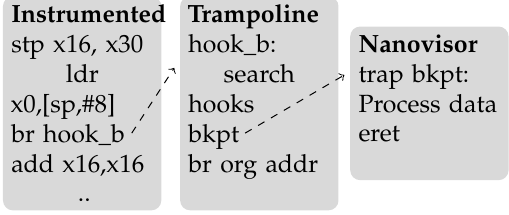
Figure 4. A C − FLAT Program in